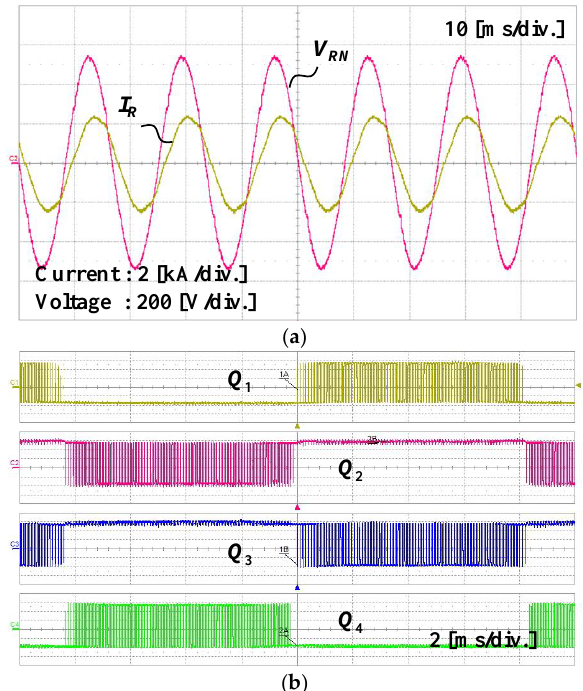
Figure 16. Experimental results in the case where the power factor is controlled at 0.9 (lag) using the proposed switching scheme: ( a ) waveforms of the output voltage and current; ( b ) waveforms of the gate signal.